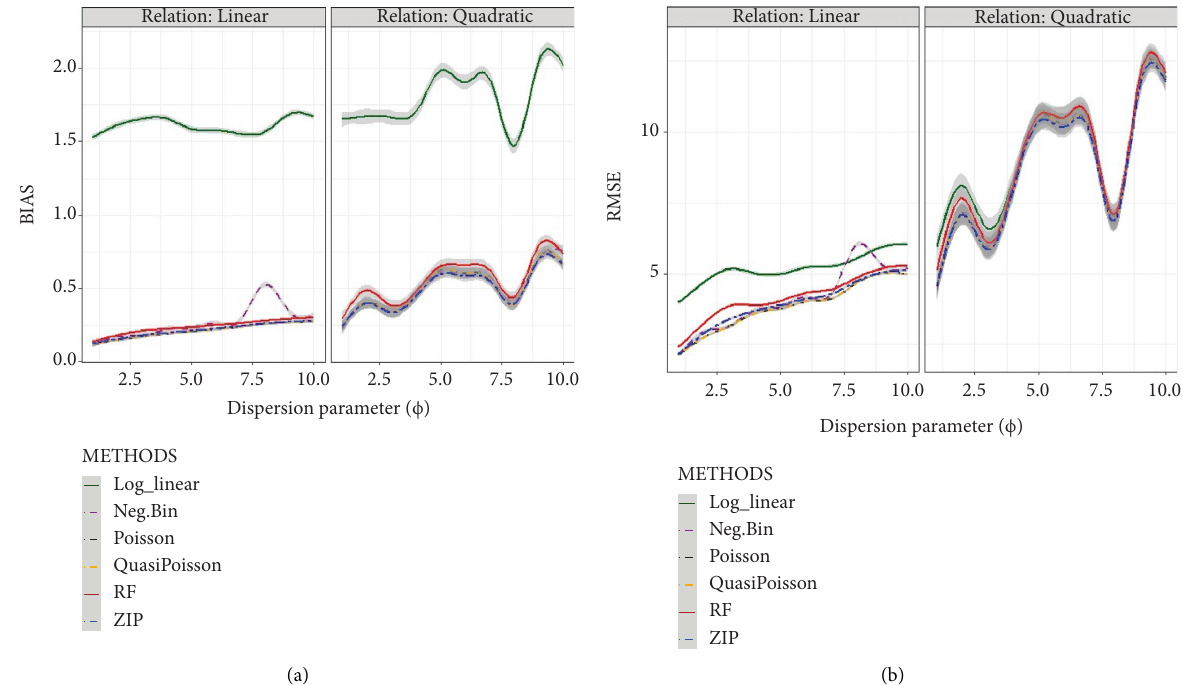
Figure 6: Efect of overdispersion on RF predictive performance compared to GLM models (relation is the outcome’s variance-to-mean relationship). (a) | Bias | and (b)